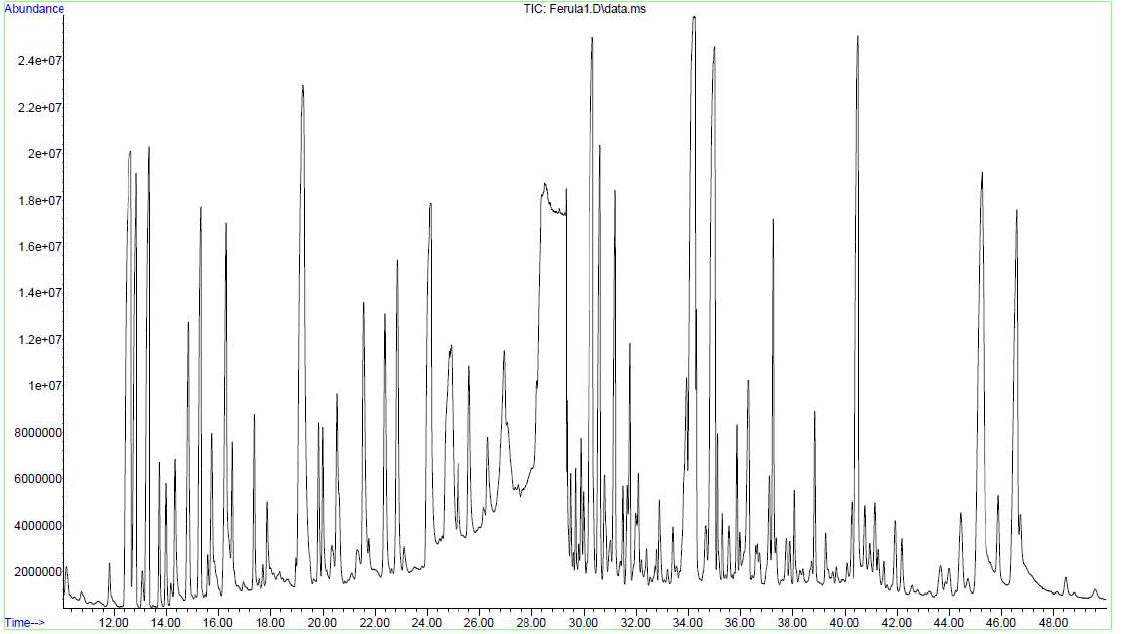
Fig. 3. Chromatogram of Ferula asafoetida L . extract obtained by CO